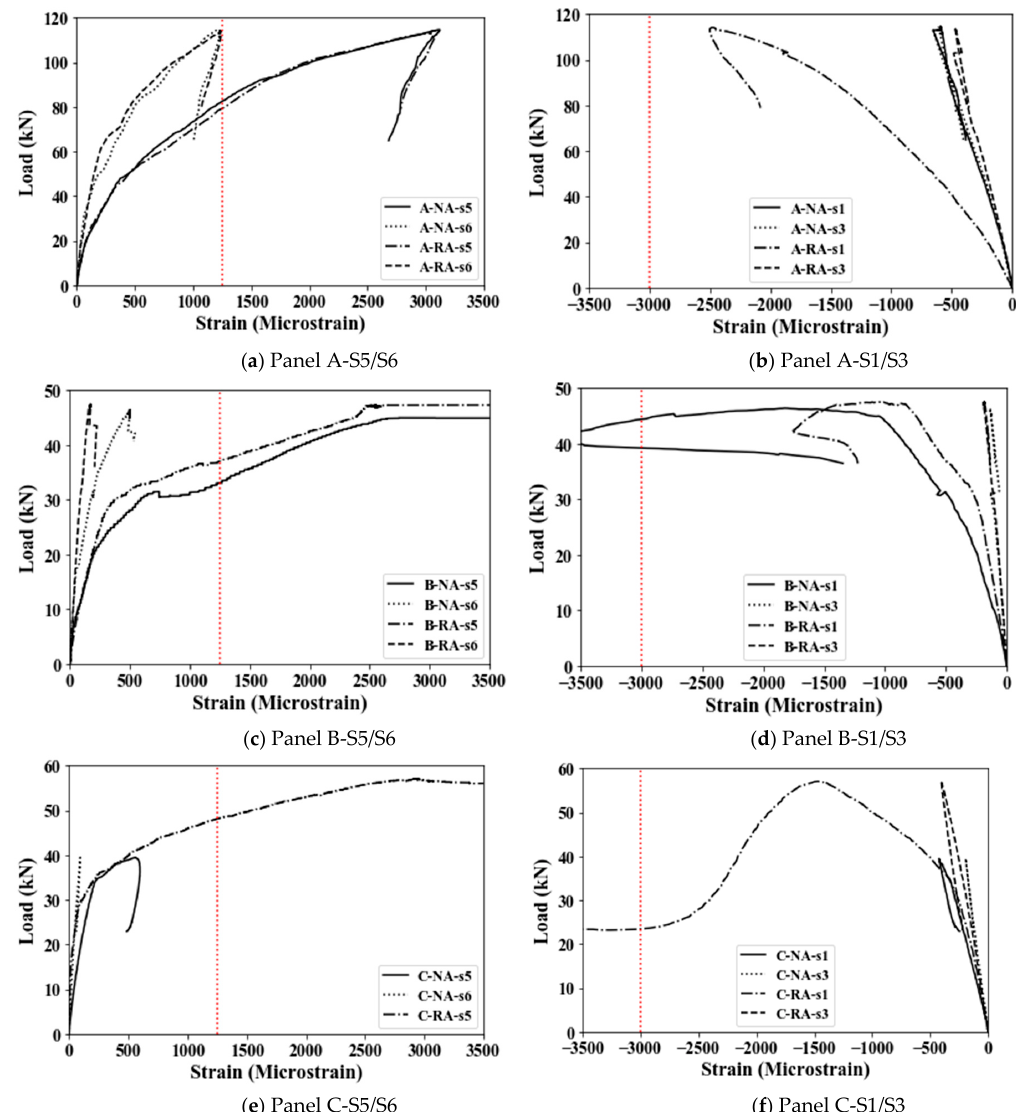
Figure 10. Failure patterns of composite deck panels.